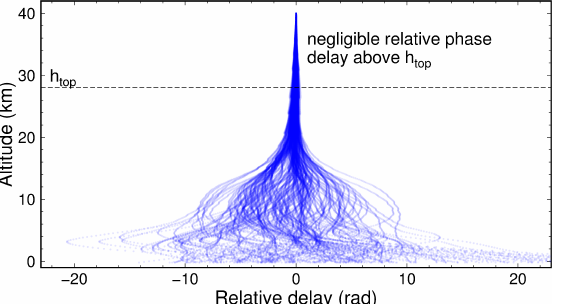
Figure 6. Relative tropospheric phase delay along the vertical direction. The darker the color is, the more the scatters overlap.